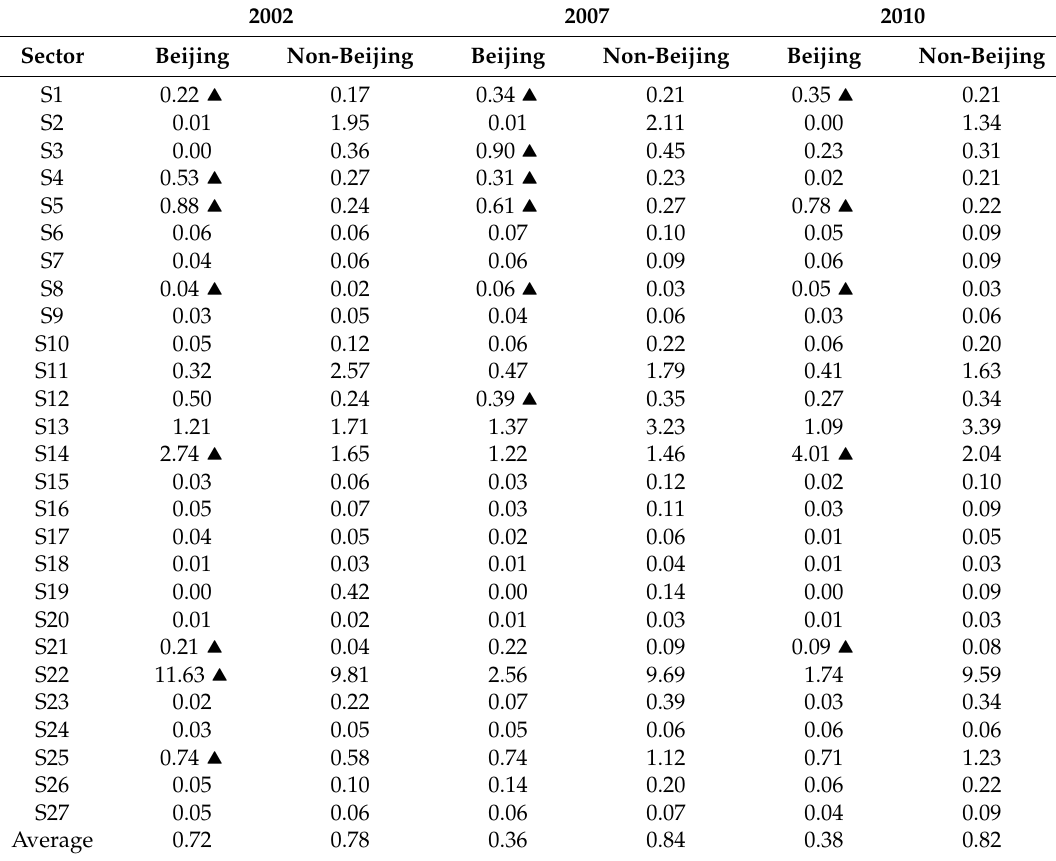
Table 5. Comparison of CO 2 emission intensities, between Beijing and non-Beijing areas (tons/ten thousand